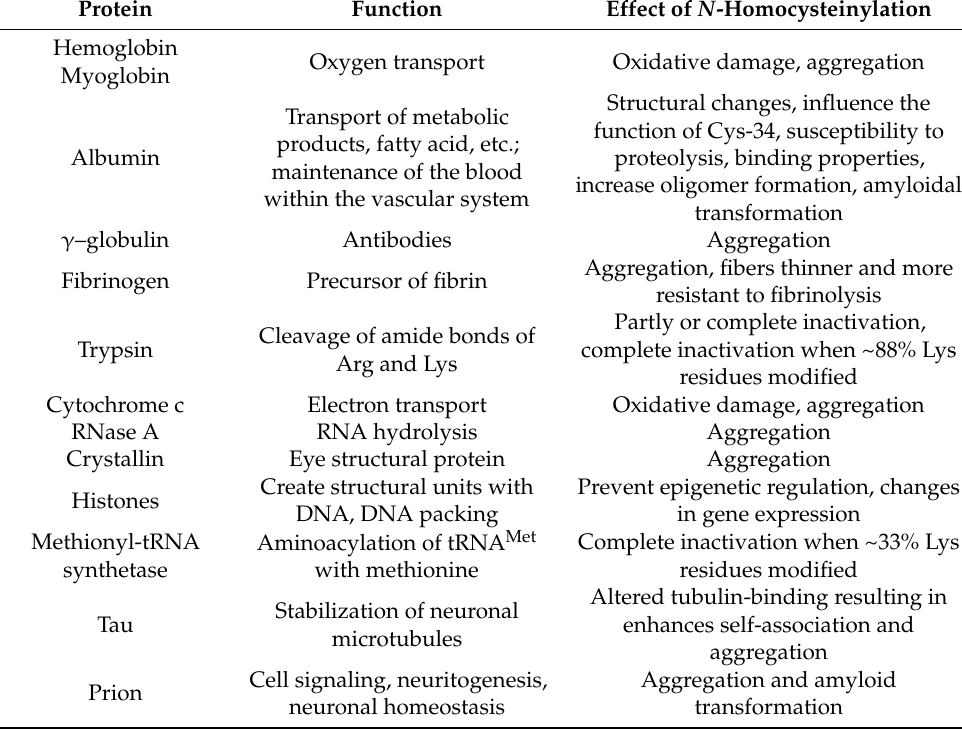
Cell signaling, neuritogenesis, Prion neuronal homeostasis